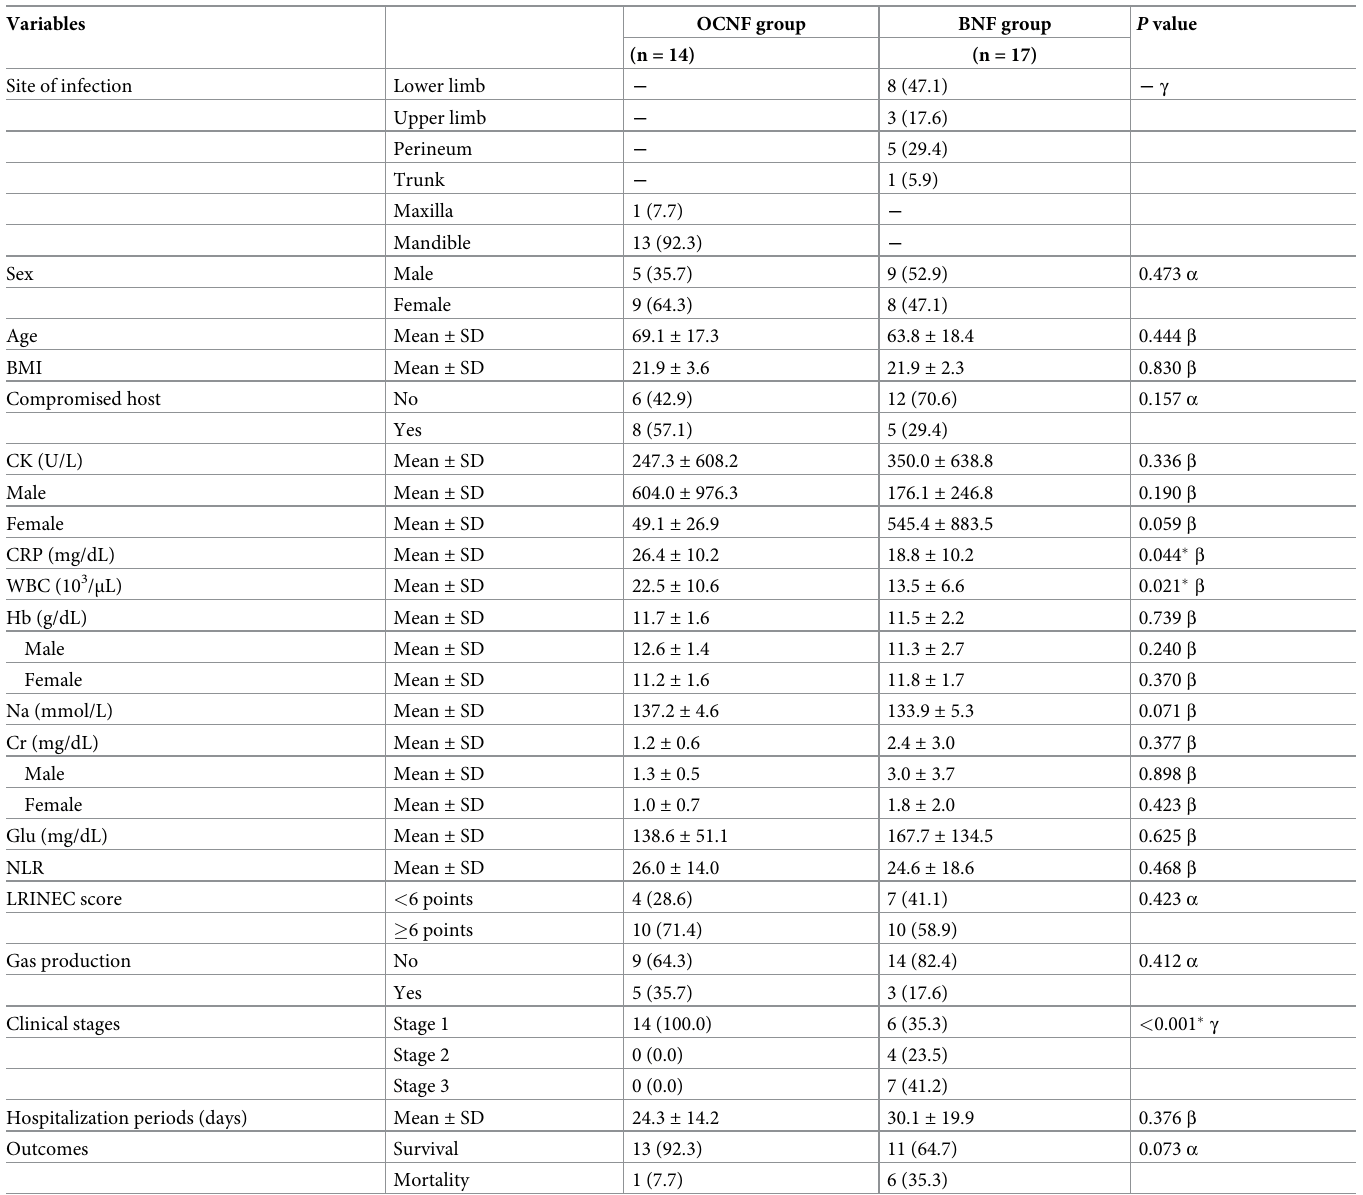
Table 5. Comparison of OCNF group and BNF